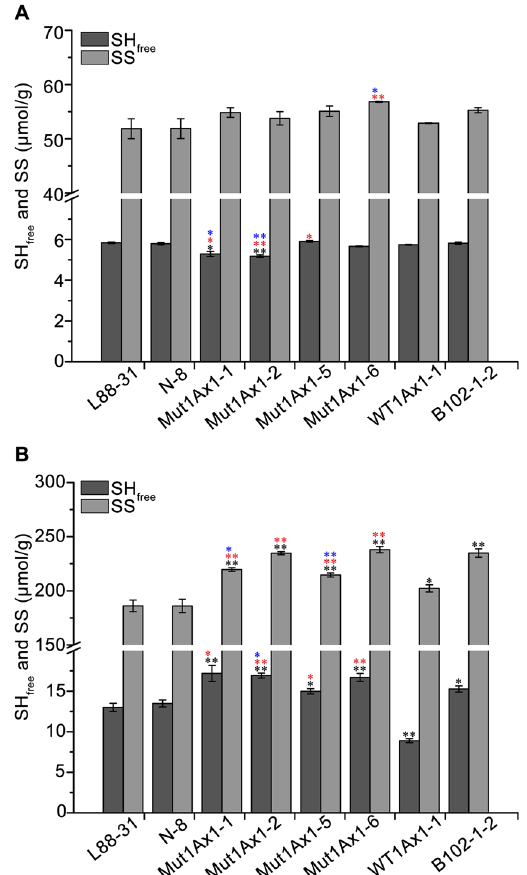
Figure 6. Comparisons of free thiol and disulfide groups in flours and glutens from transgenic and control wheat lines. ( A ) Relative contents of free thiol and disulfide groups in flour samples from all lines. ( B ) Relative contents of free thiol and disulfide groups in ground freeze-dried samples from all lines. Bars represent the mean ± SEM. At least three biological experiments were performed. * / ** Show the comparisons between all transgenic lines and negative controls (L88-31 and N-8) on the contents of free thiol and disulfide groups, while and represent comparisons between transgenic lines expressing mut1Ax1 and line WT1Ax1-1 and comparisons between those lines and line B102-1-2, respectively ( * P < 0.05, ** P < 0.01 by Student’s